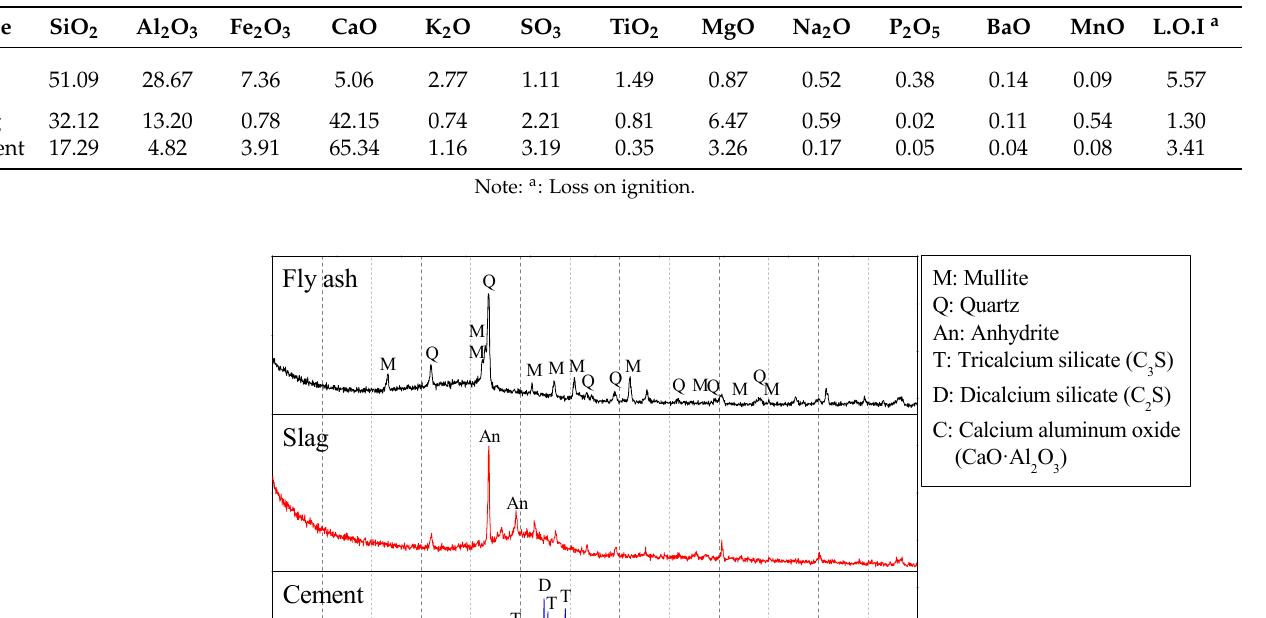
Table 1. XRF results of fly ash, slag and cement (Unit: %).